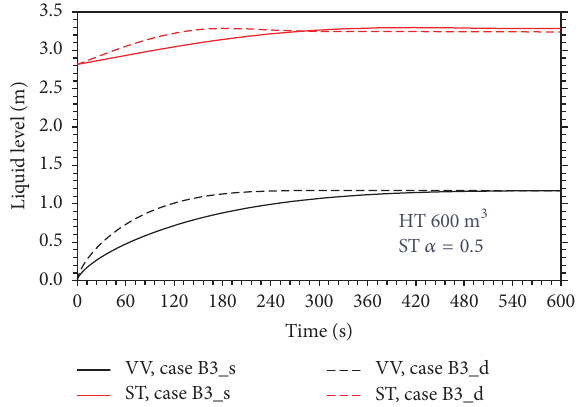
Figure 14: Liquid level in the VV and ST.